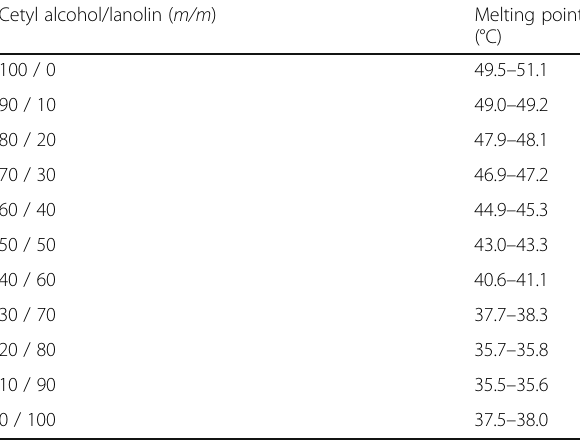
Table 1 Melting ranges of different cetyl alcohol/lanolin mixtures